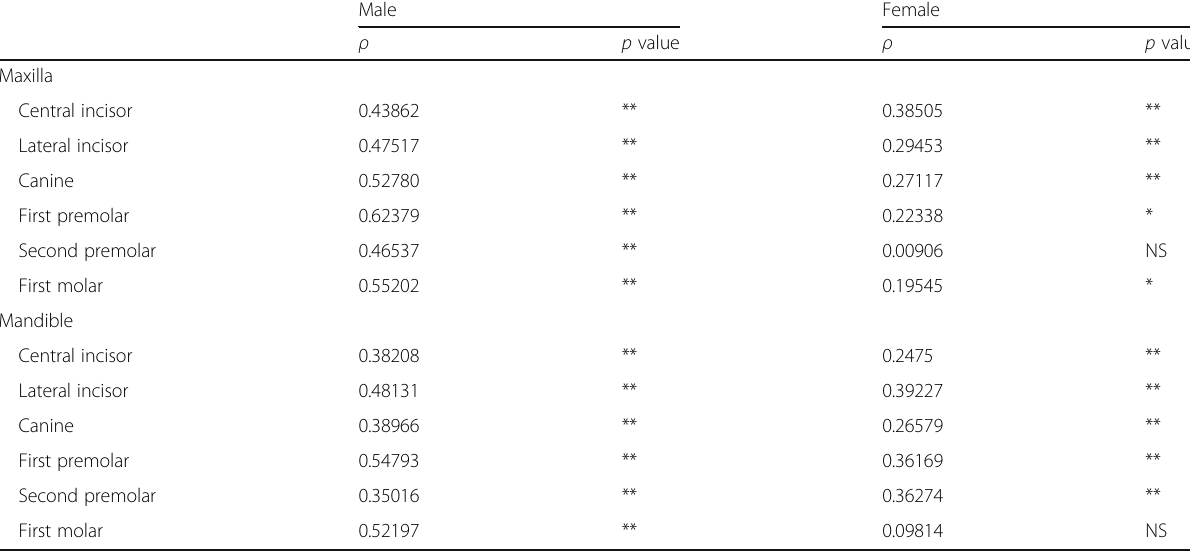
Table 2 Correlation between congenitally missing tooth number and tooth size